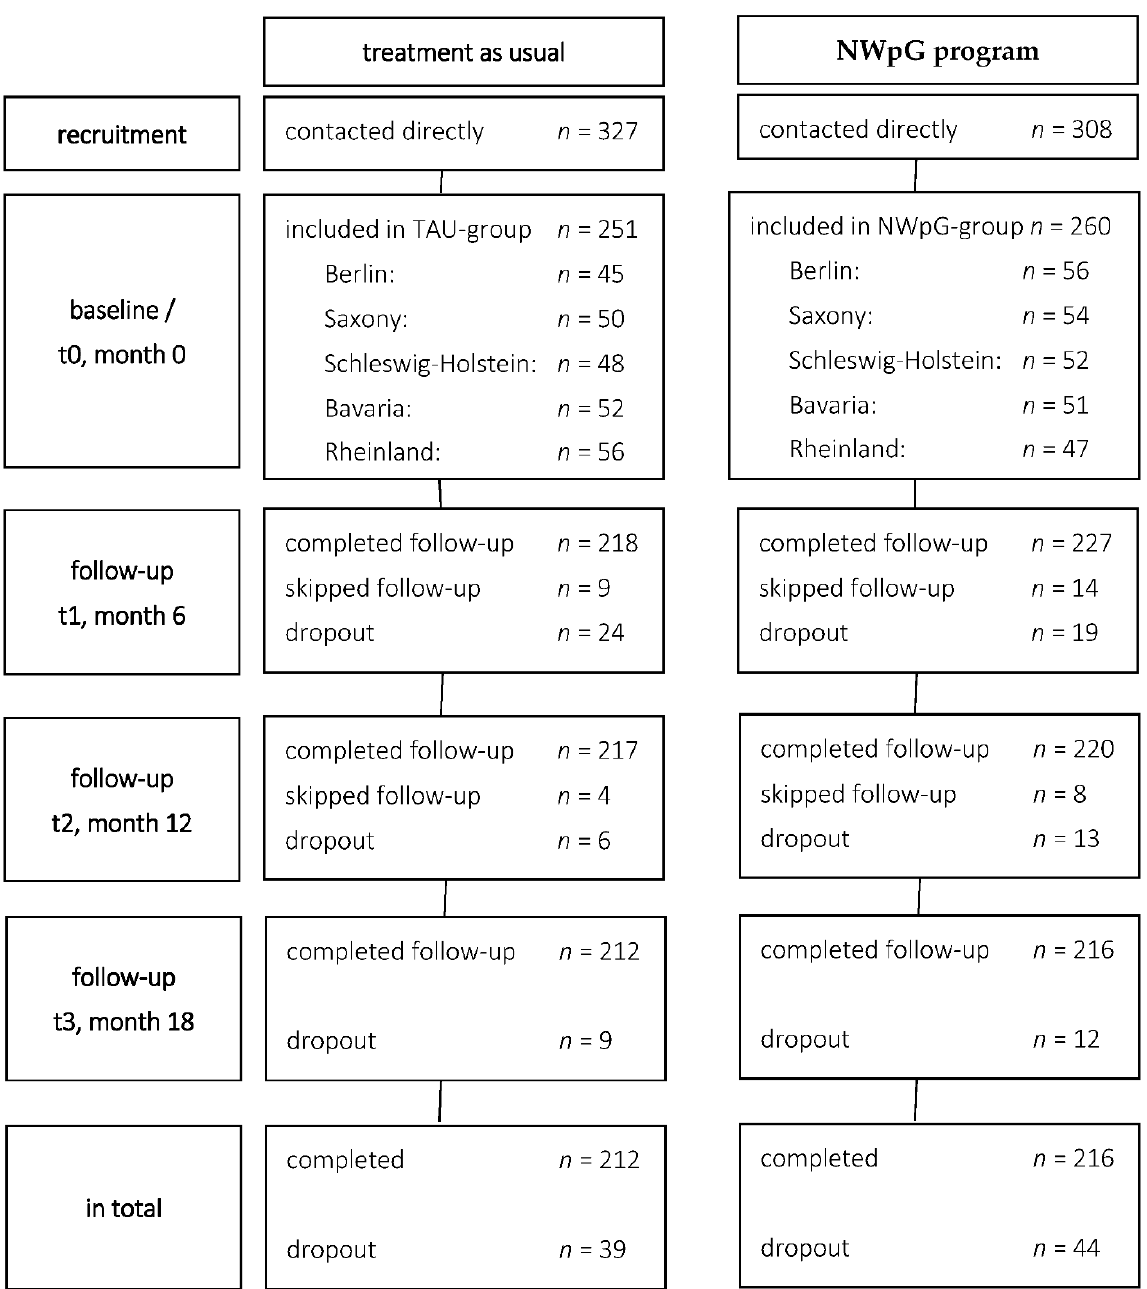
Figure 1. Flow of study participants: contacted directly—number of patients that were contacted and informed by study staff; completed follow-up—number of patients that completed follow-up (regardless of re-allocation); skipped follow-up—number of patients that skipped follow-up, but continued later on; dropout—number of patients who dropped out.